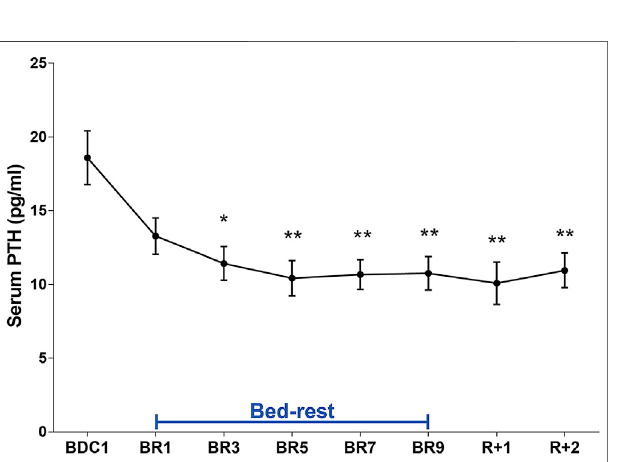
FIGURE 4 | Serum PTH (pg/ml) during 10-day bedrest. Data are expressed as mean ± S.E.M. Statistical analysis was done using Ordinary one-way Anova test (* p < 0.05 for BR3 vs. BDC1; ** p < 0.01; for BR5, BR7, BR9, R+1 and R+2 vs. BDC1).